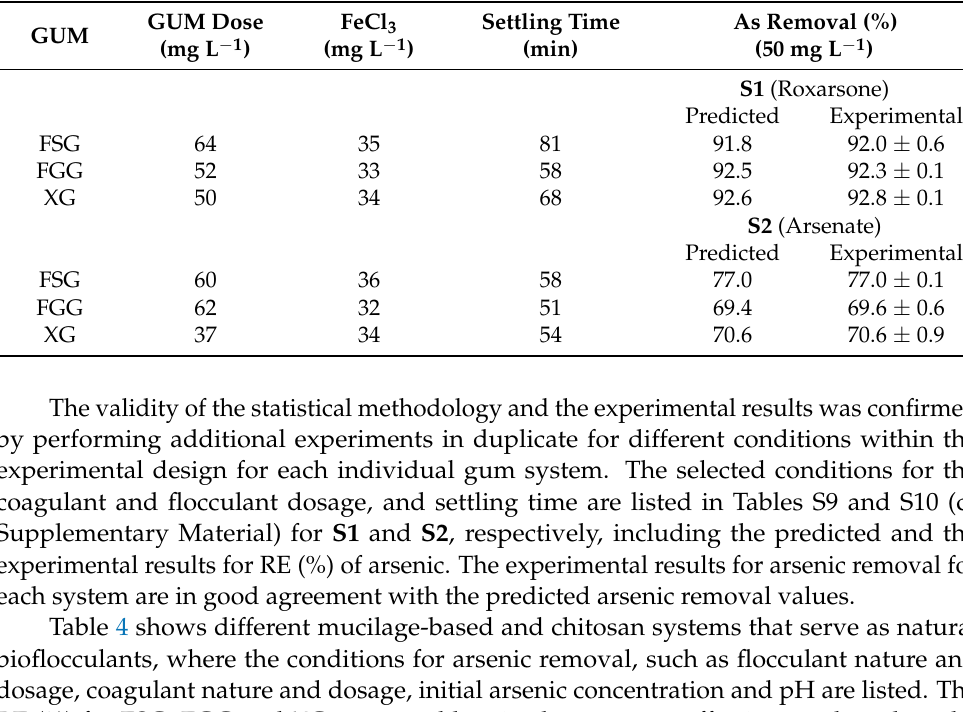
Table 3. Results of confirmation experiments under optimized conditions at 295 K.